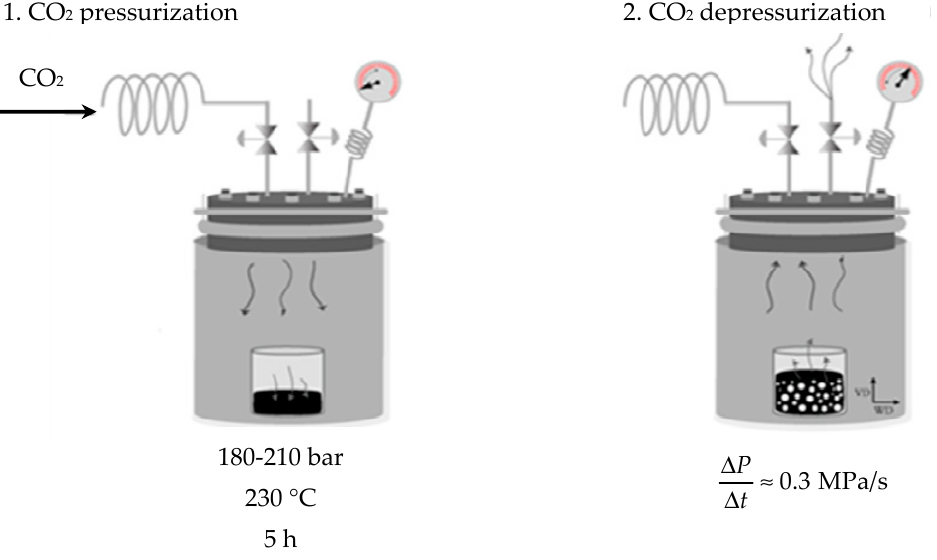
Figure 1. Scheme of the one-step scCO 2 foaming process.